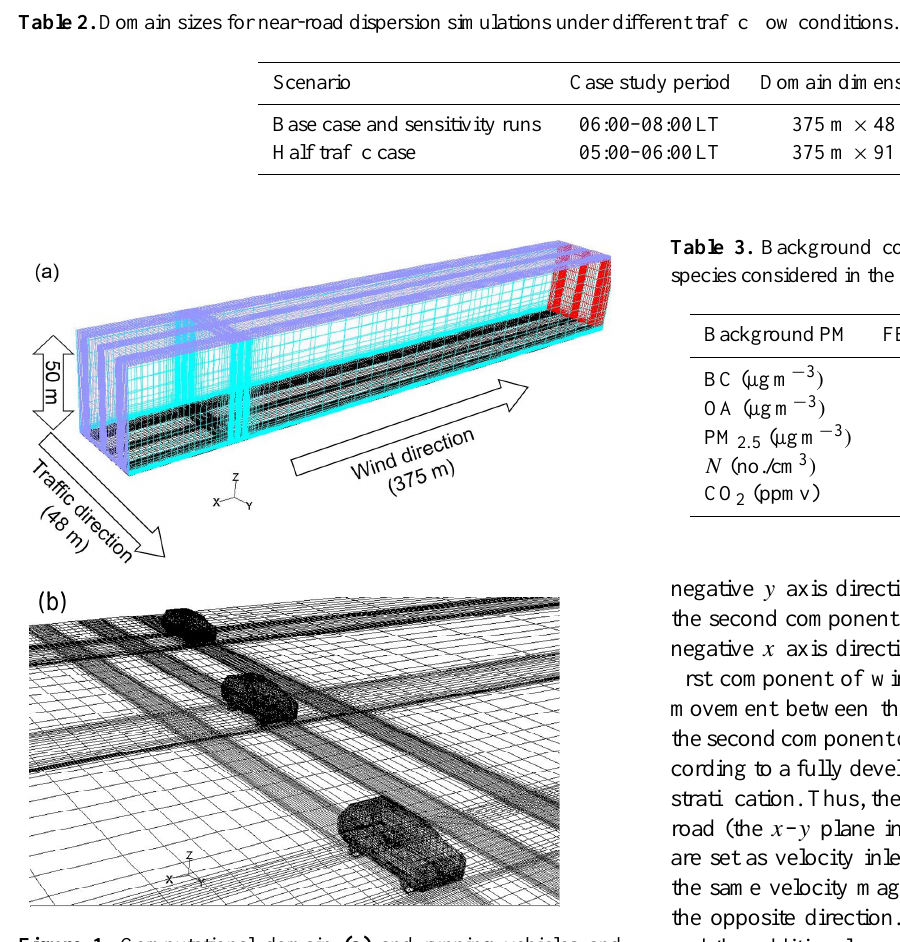
Fig. 1. Computational domain (a) and running vehicles and ground mesh (b). Purple mesh 4 Figure 1. Computational domain (a) and running vehicles and ground mesh (b) . Purple mesh indicates velocity-inlet boundaries indicates velocity-inlet boundaries (left and top); Red mesh indicates pressure-outlet 5 (left and top); red mesh indicates pressure-outlet boundary (right); boundary (right); Black mesh indicates wall boundaries (bottom and cars); and cyan mesh 6 black mesh indicates wall boundaries (bottom and cars); and cyan indicates translational periodic boundaries (lateral). 7 mesh indicates translational periodic boundaries (lateral).